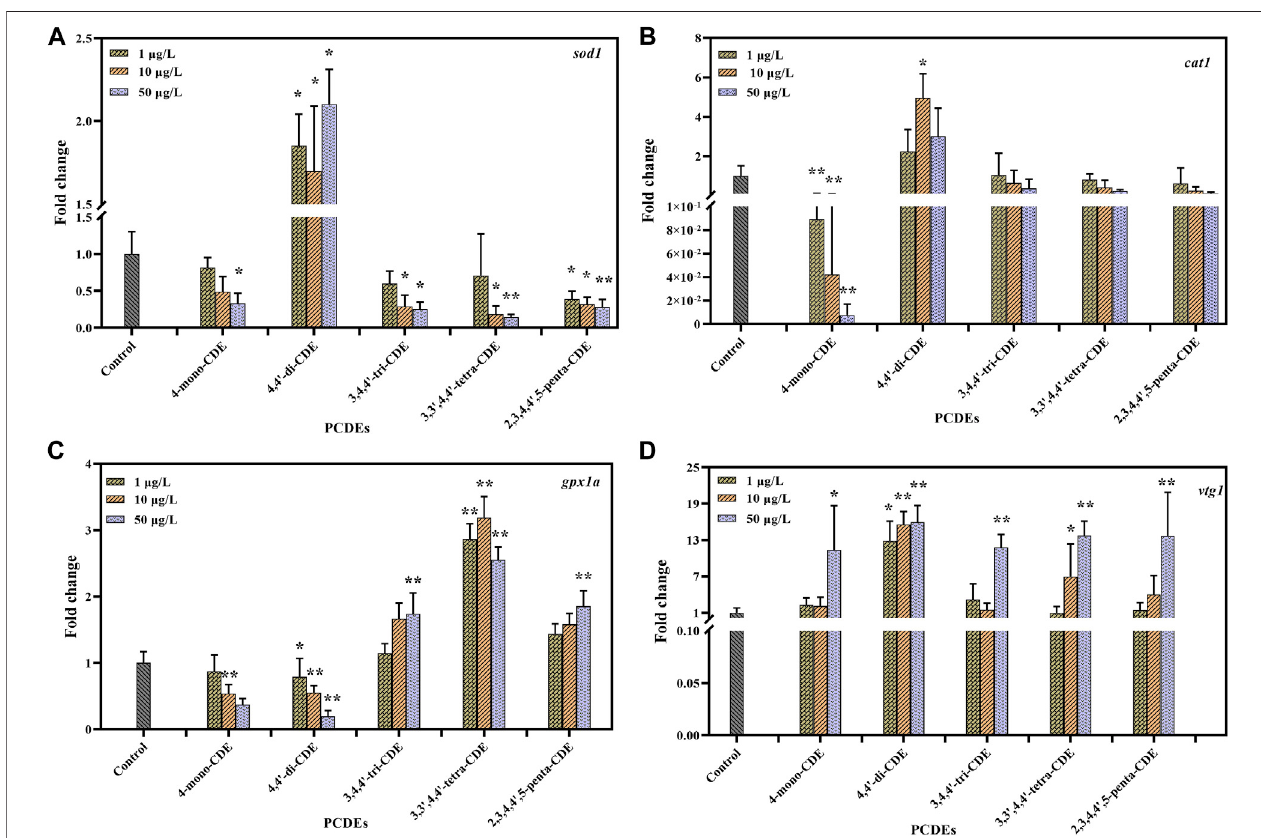
FIGURE 11 | Effects of PCDEs on the mRNA expression levels of cat1 (A) , sod1 (B) , gpxla (C) , and vtg1 (D) in the liver of adult male zebra fi sh. The data are presented as mean ± SD.